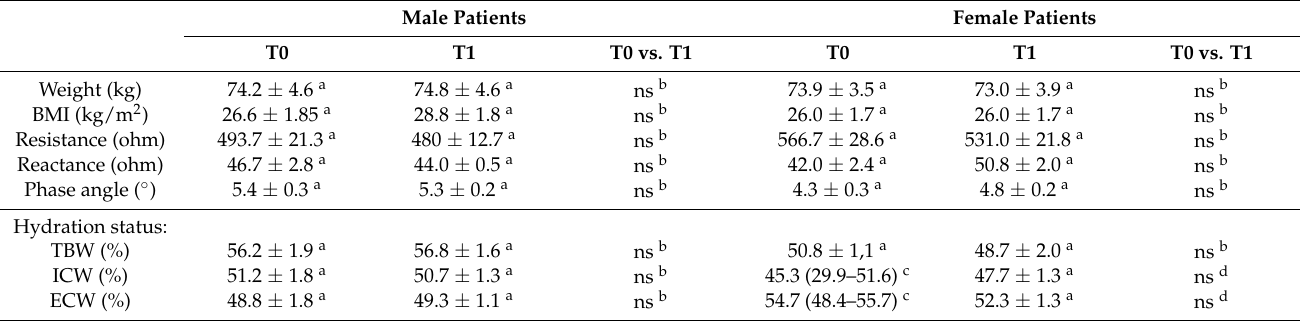
Table 5. Body composition assessment of two subgroups of OFS